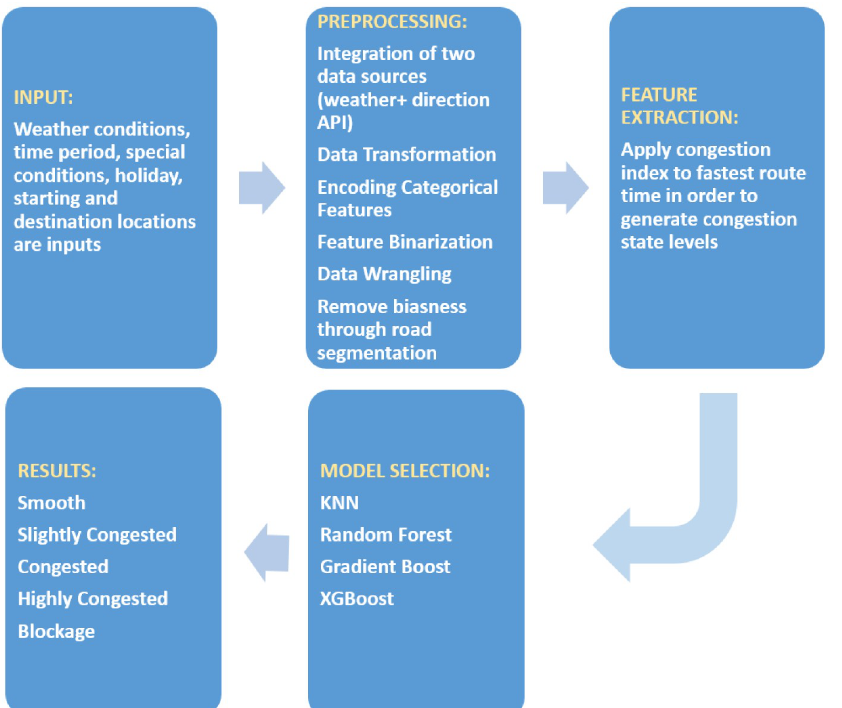
Fig 1. Methodology of traffic congestion